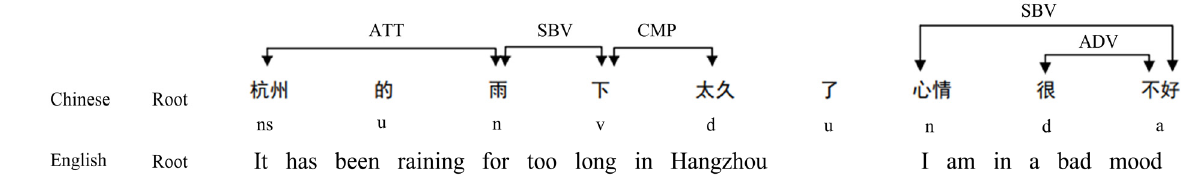
Figure 1. The syntactic analysis of the case.